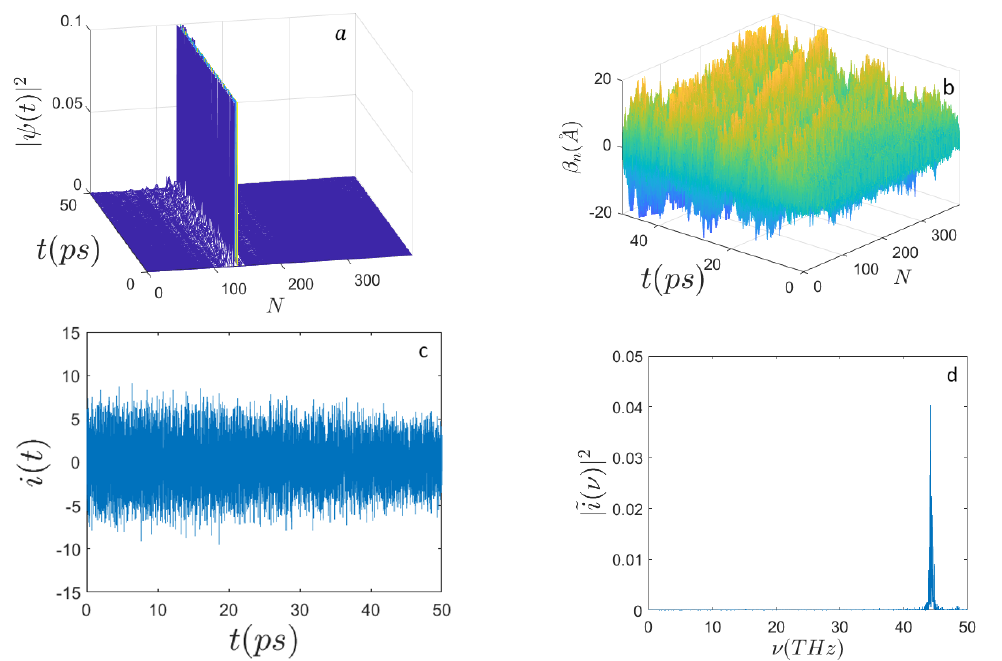
Figure 3. Time evolution of ( a ) the electron probability amplitude | Ψ ( t ) | 2 ; ( b ) the average displace- ments β n ( ˚ A ) ; ( c ) the electron current i ( t ) (expressed in µ biot); ( d ) the frequency spectrum | ˜ i ( ν ) | 2 along the sequence of N = 398 nucleotides, with the initial condition E 0 = 0.79 eV ( E (cid:48) = 120) and the initial electron excitation peaked around the site n 0 = N /3. The other parameters are the same as those in Figure